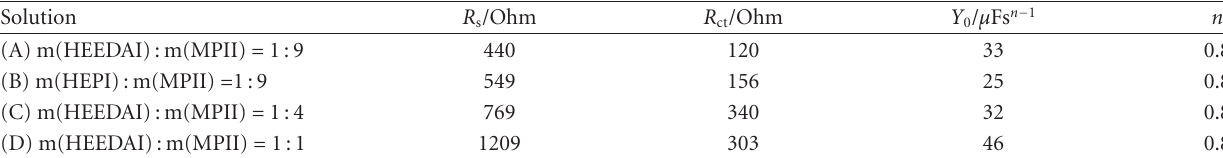
Table 2: Parameters obtained by fitting the experimental spectra with the equivalent circuit. Solution